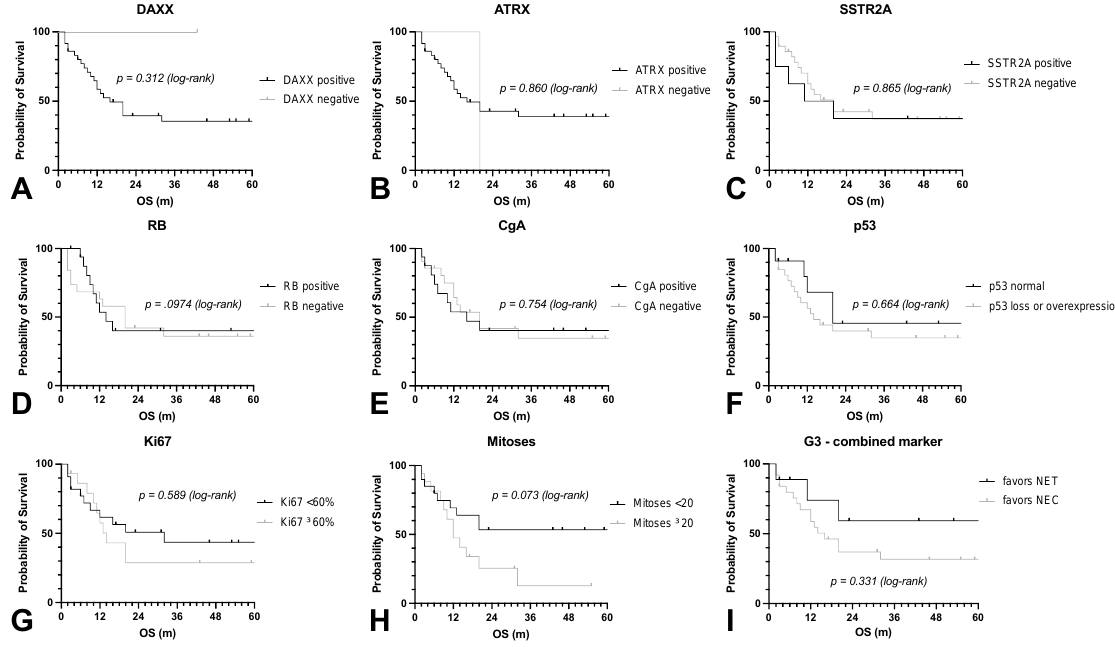
p53 normal p53 loss or overexpression p = 0.664 (log-rank)